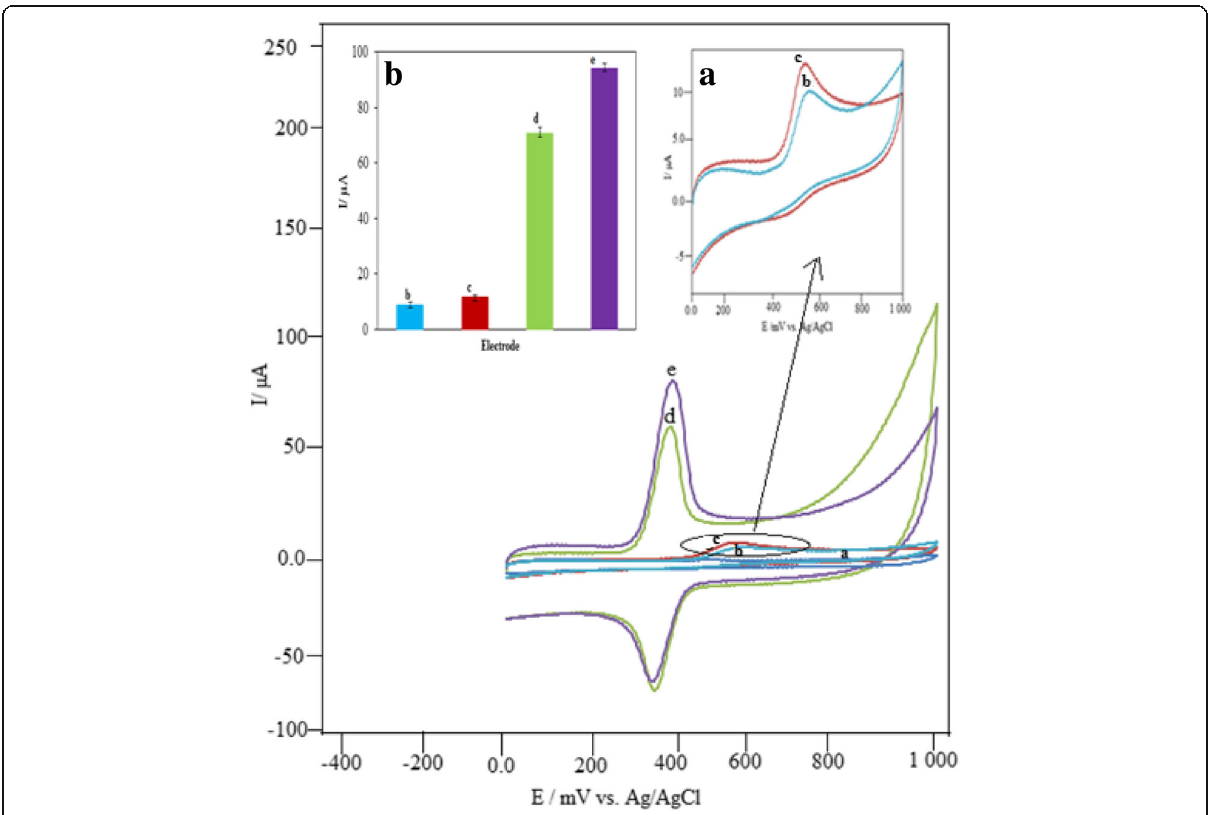
Fig. 4 CVs of GCE (curve a) in PBS (0.1 M, pH 4.0), GCE (curve b), B 2 O 3 / GCE (curve c), MWCNT/GCE (curve d), and Bi 2 O 3 / MWCNT/GCE (curve e), in 0.1 mM paracetamol (0.1 M PBS, pH 4.0). Scan rate: 100 mV s −